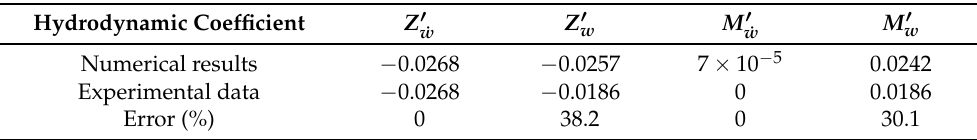
Table 12. Validation of PMM test simulation by comparing the numerical solution with the reported data [42].